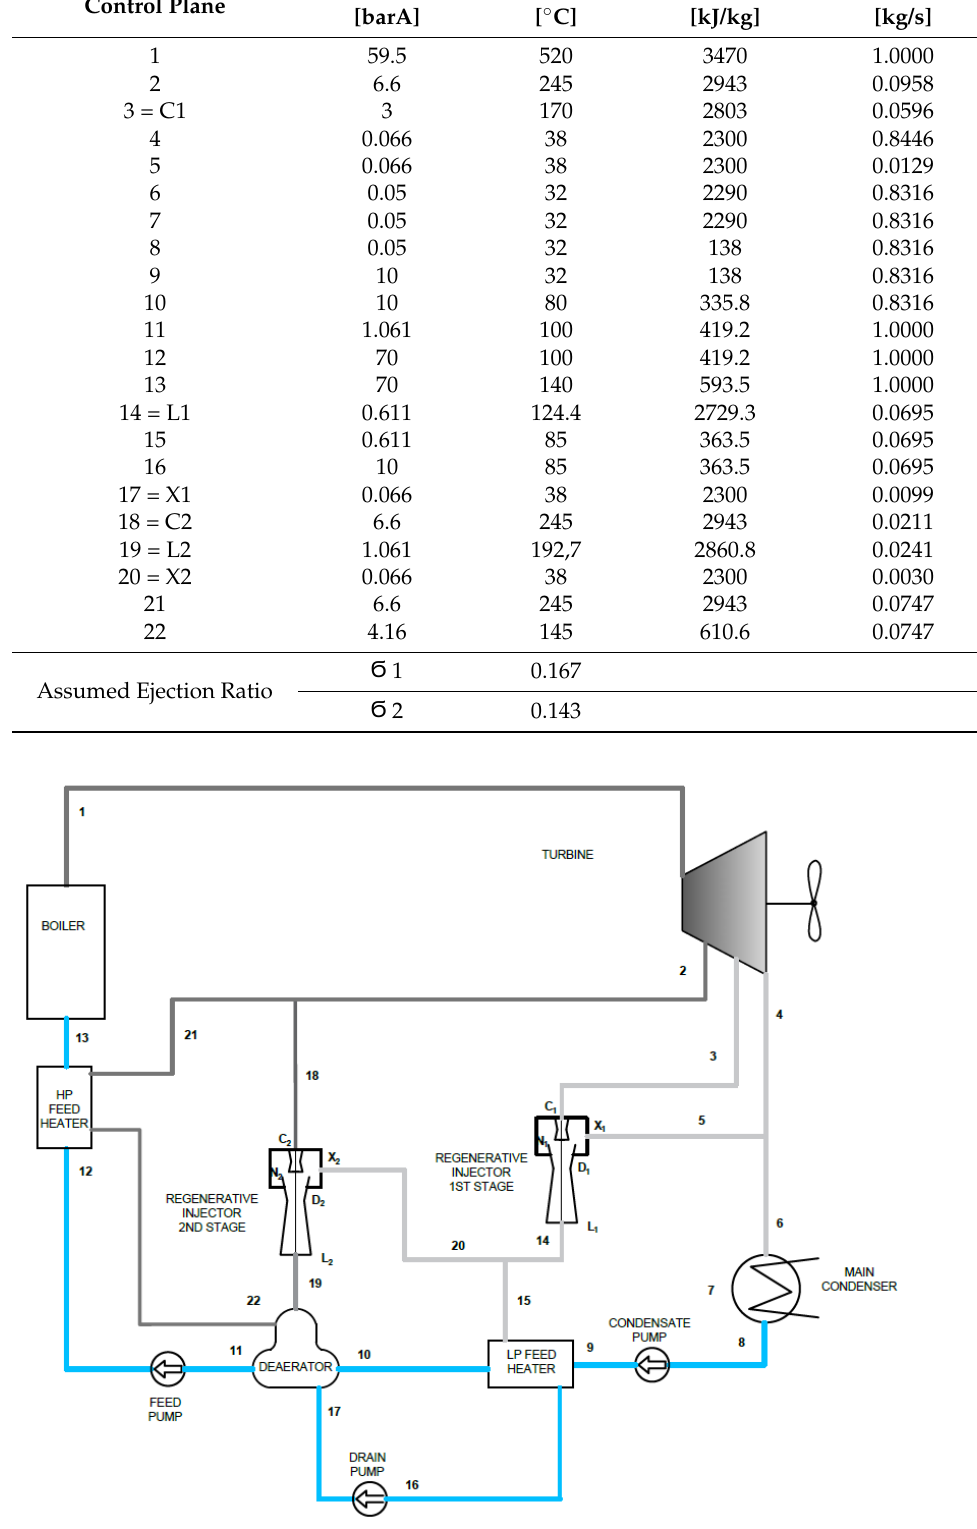
Figure 10. Thermal flow diagram of the regenerative cycle with two-stage injectors.